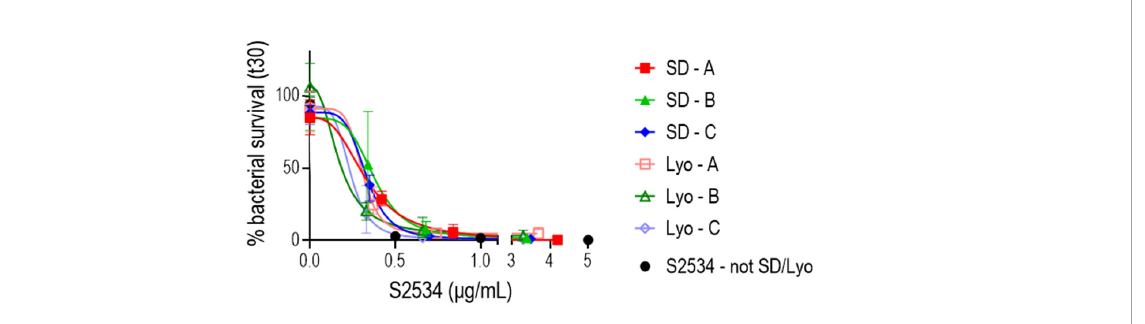
FIGURE 10 S2534 (Fc3/FH*) retains bactericidal activity after spray drying or lyophilizing. S2534 was spray-dried (SD) or lyophilized (Lyo) using three different formulations (A, B or C), as shown in Table 2. The bactericidal activity of each formulation reconstituted in water at concentrations of S2534 ranging from 0 to 5 µg/mL against strain FA1090 was determined. Each data point shows the mean (standard error) of 3 separate experiments. The calculated IC50 for SD – A, SD – B, SD – C, Lyo – A, Lyo – B and Lyo – C were 0.32, 0.38, 0.32, 0.29, 0.17 and 0.22 µg/mL, respectively. The IC50 for the native (not SD or lyophilized) S2534 could not be calculated because 97% killing was seen at the lowest concentration (0.5 µg/mL) tested. There were no statistical differences across the SD or Lyo groups by two-way